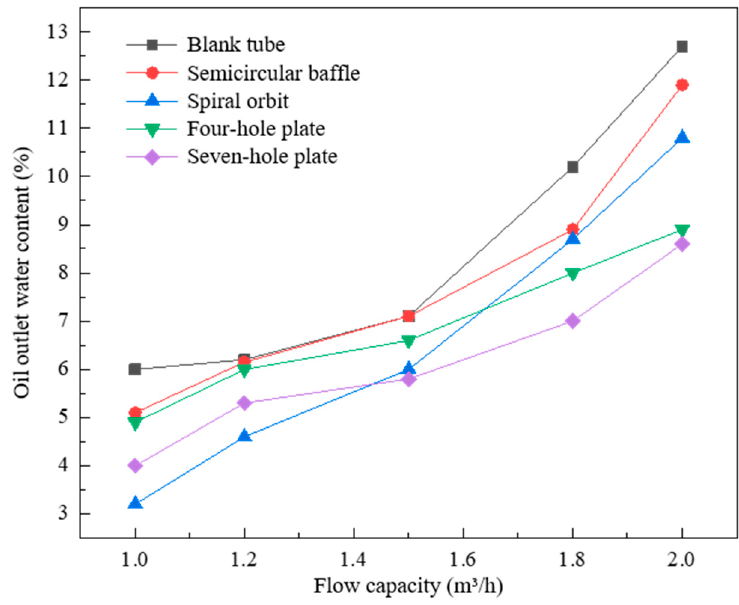
Figure 14. Water content at the oil outlet of different flow rates.